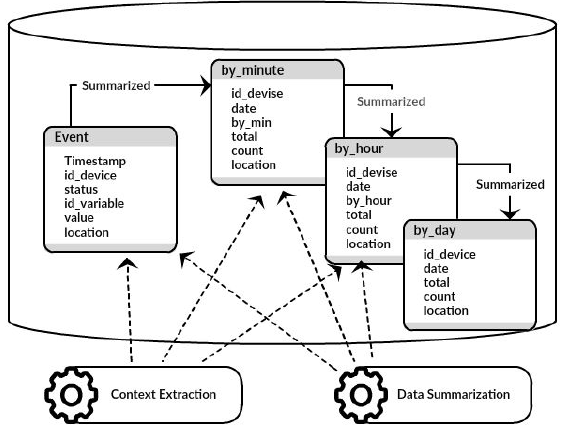
Figure 6. Data aggregation component.